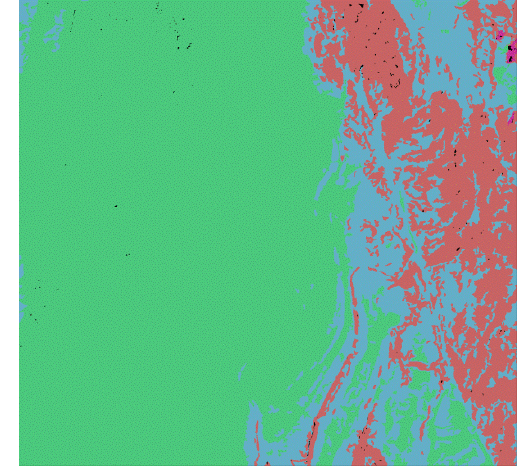
Figure 5 – ICESAT “truth points” over the geocell. Three different orbits can easily be identified. Colours show the magnitude of the elevation difference (in meters) between ICESAT measurements and the AJAX DEM.